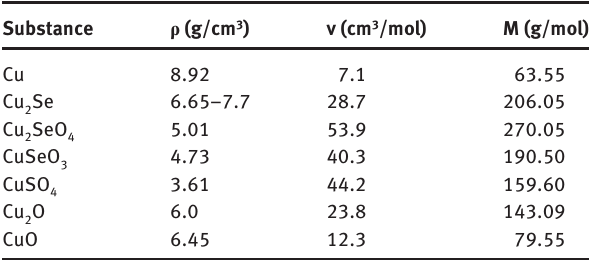
+ P SeO = 1, 2 (g) 2 (g)